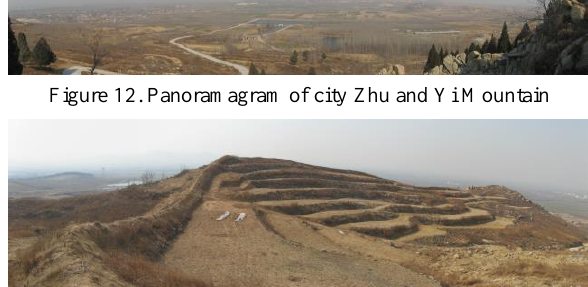
Figure 13. The remains of the city wall on Kuo Mountain